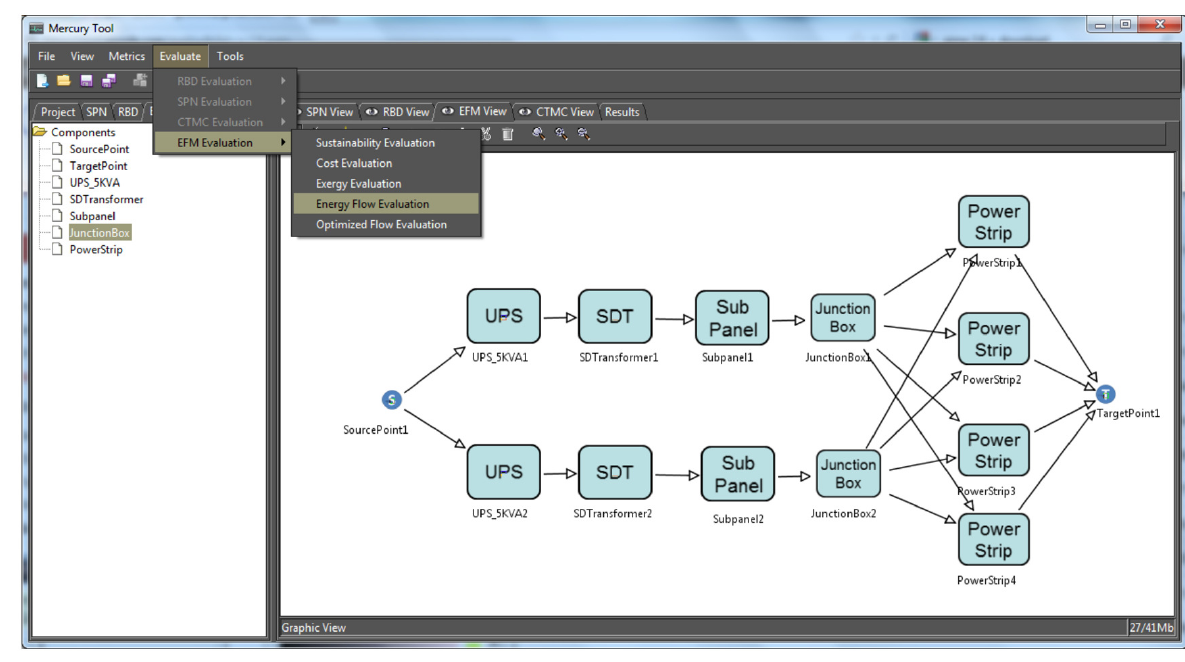
Figure 11. EFM editor and